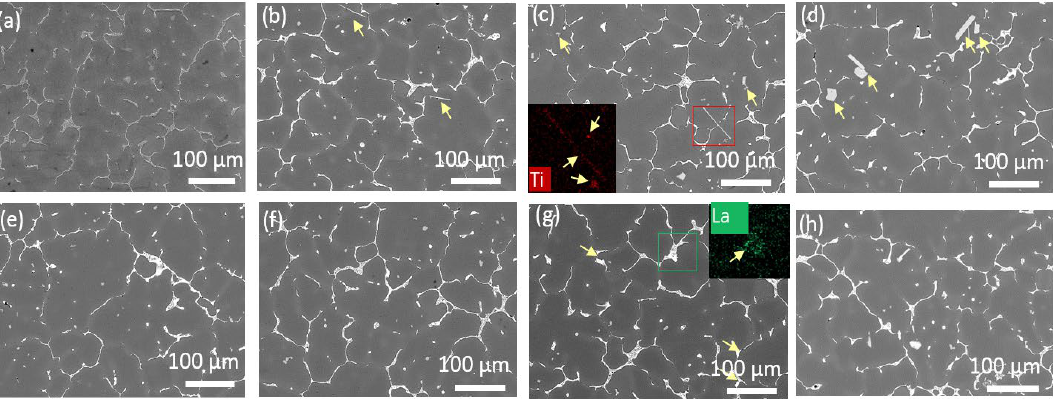
Figure 6. Microstructure of ZL205A alloy with different levels of Al–Ti–C or La: ( a ) ZL205A, ( b ) 0.1% Al–Ti–C, ( c ) 0.3% Al–Ti–C, ( d ) 0.7% Al–Ti–C, ( e ) 0.05% La, ( f ) 0.1% La, ( g ) 0.15% La, ( h ) 0.3% Al–Ti–C+0.1% La. The inset in ( c , g ) is the EDS mapping of the highlighted region.